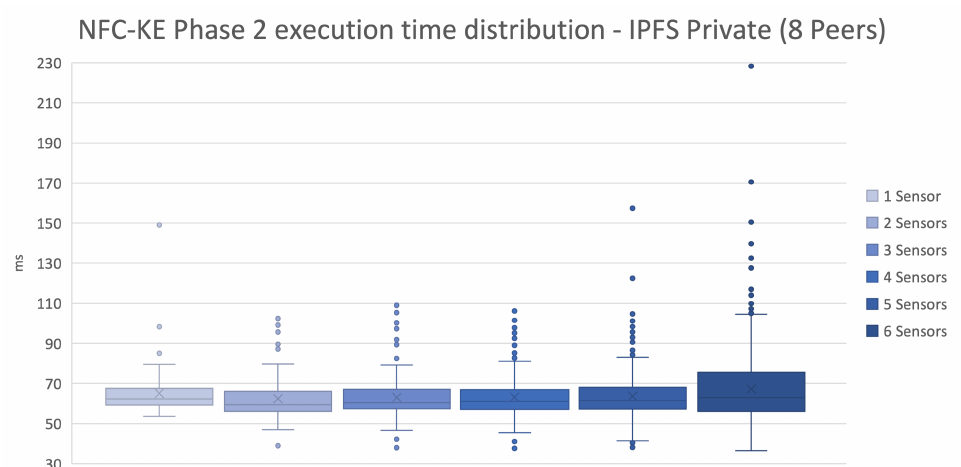
Figure 6. NFC-KE Phase 2 execution time distribution-IPFS private-8